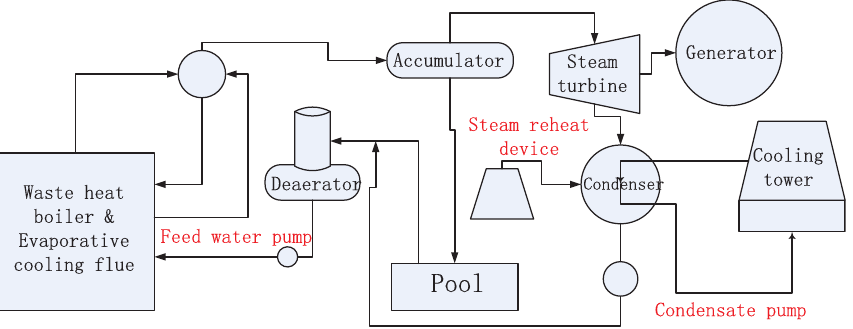
Figure 4: EAF saturated steam waste heat power generation